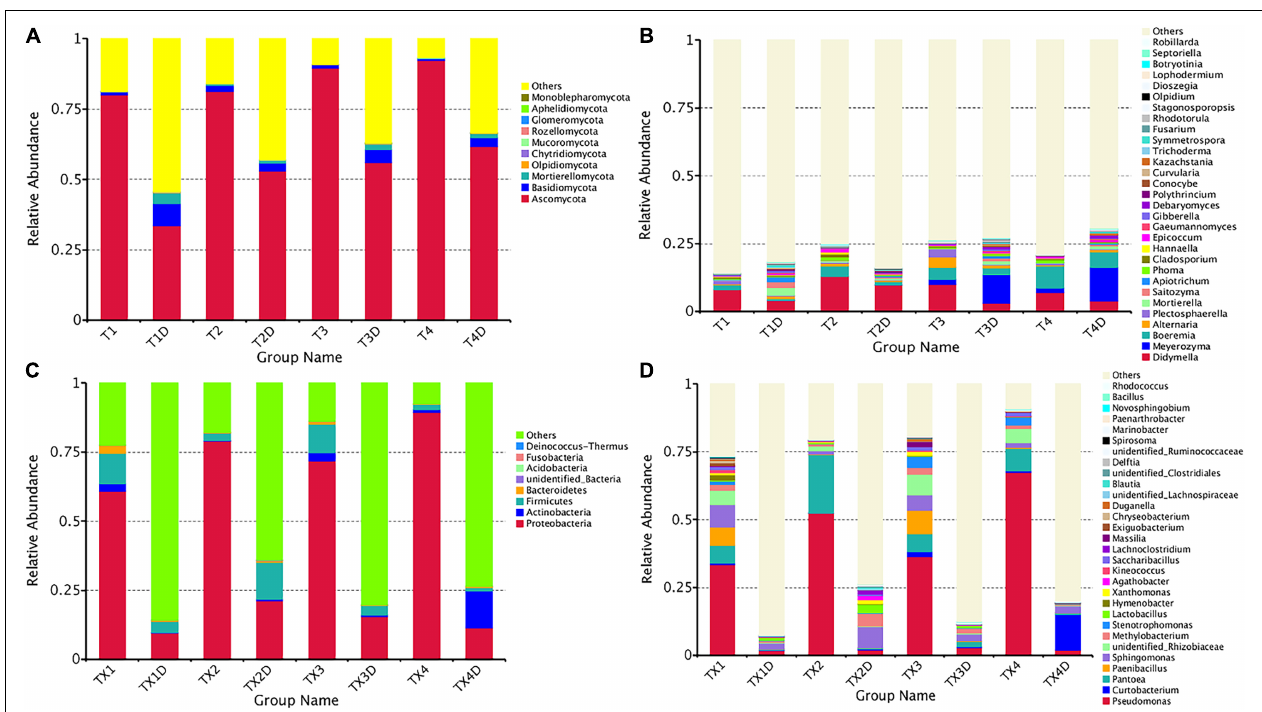
FIGURE 4 | Microbial community composition of different groups at the phyla and genus levels. Fungal community composition of different groups at the phyla (A) and genus (B) levels. Bacterial community composition of different groups at the phyla (C) and genus (D) levels. Phyla making up less than 0.01 of total composition were classified as